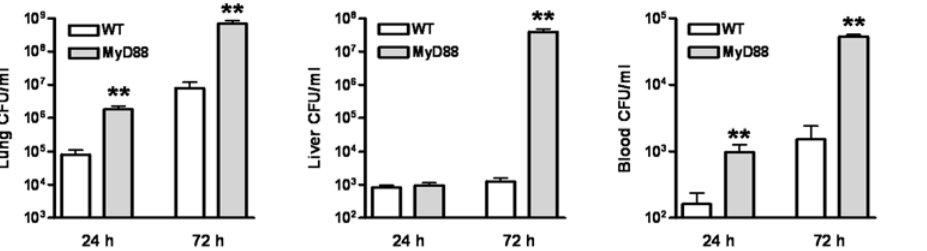
Figure 3. MyD88 KO mice show increased bacterial outgrowth during experimental melioidosis. WT and MyD88 KO mice were intranasally infected with B. pseudomallei (5 6 10 2 CFU). Bacterial loads were measured 24 h and 72 h after inoculation in lungs (A) , liver (B) and blood (C) . Data are mean 6 SEM (n=6–7 per group at each time point). ** P , 0.01.